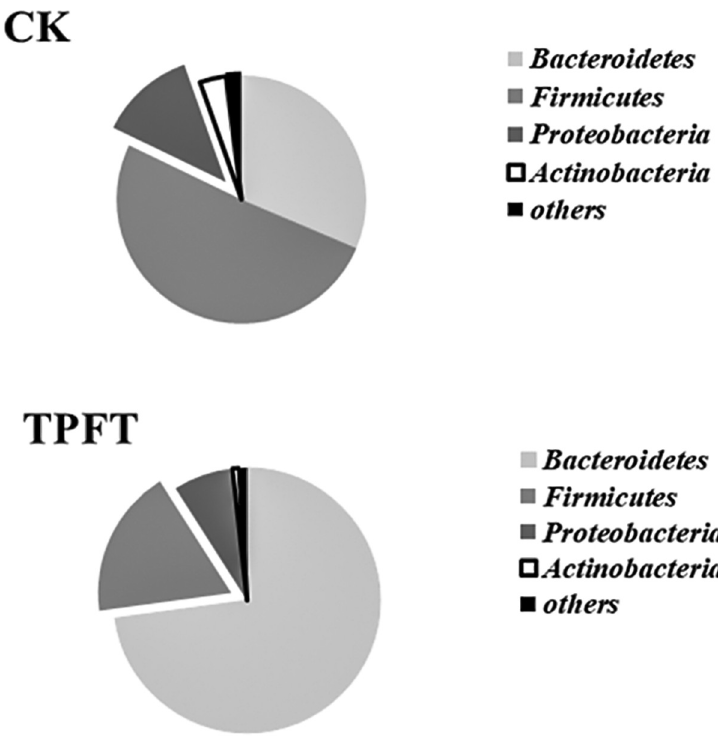
Fig 1. Effects of exclusive enteral nutrition (EEN)-n-3 polyunsaturated fatty acids (3PUFAs) on the gut microbiome (phylum level) after 8 weeks of treatment in mice compared with mice fed a regular diet. The bacteria were analyzed using the sequencing of the V4 region of the 16S ribosomal RNA. 3PUFAs-8 week: the experimental group treated with 3PUFAs for 8 weeks.